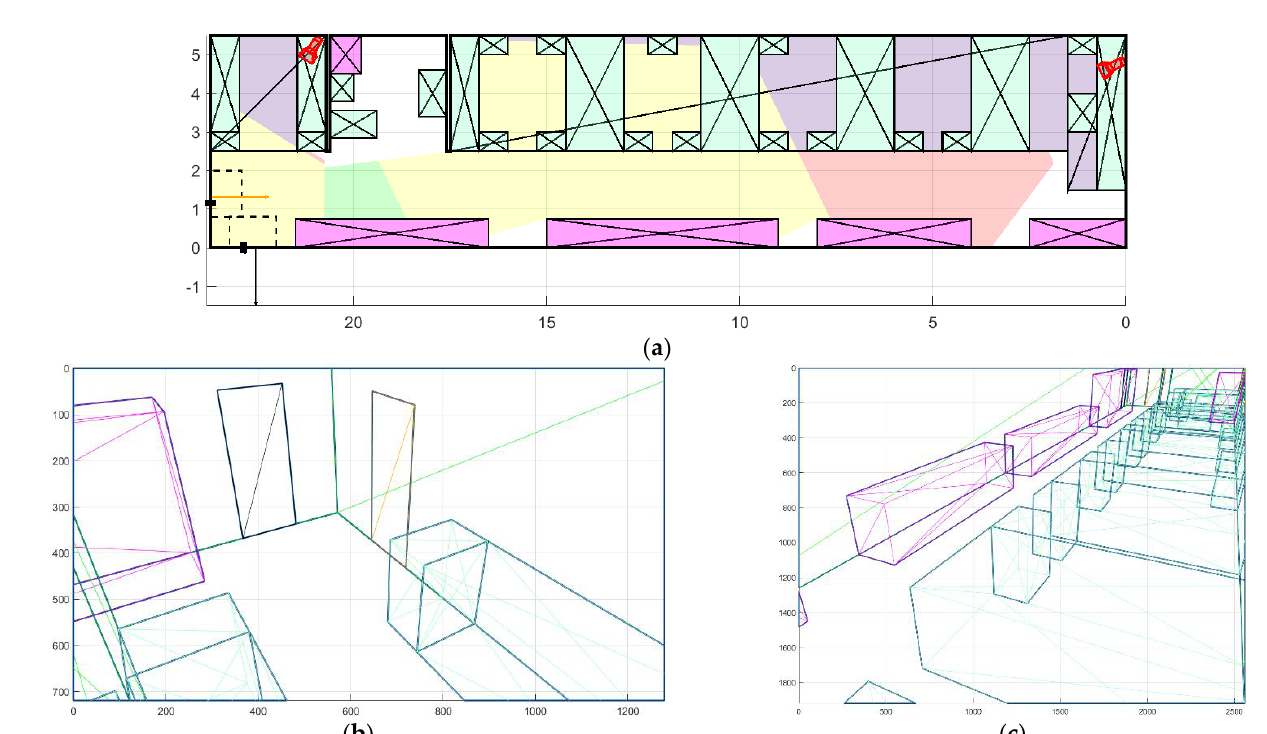
Figure 15. Placement of cameras without WDR, taking into account the windows in the room 2: ( a ) floor plan; ( b ) view from the first camera; and ( c ) view from the second camera.